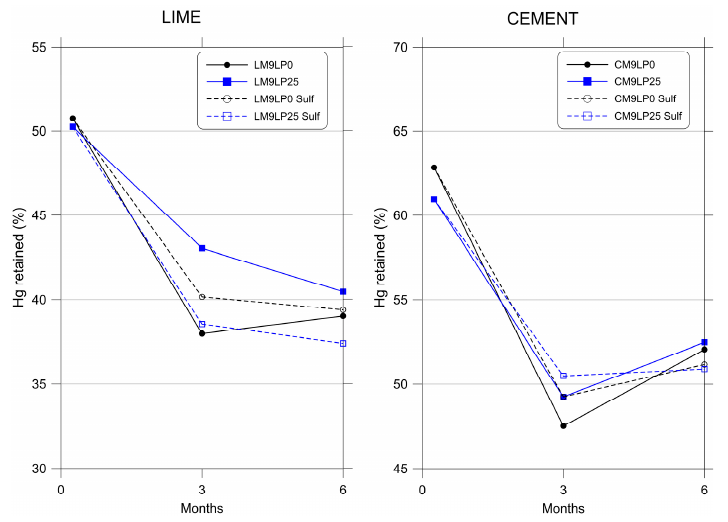
Figure 6. Hg retained for lime and cement samples with and without the industrial waste at 7 days and at 3 and 6 months.